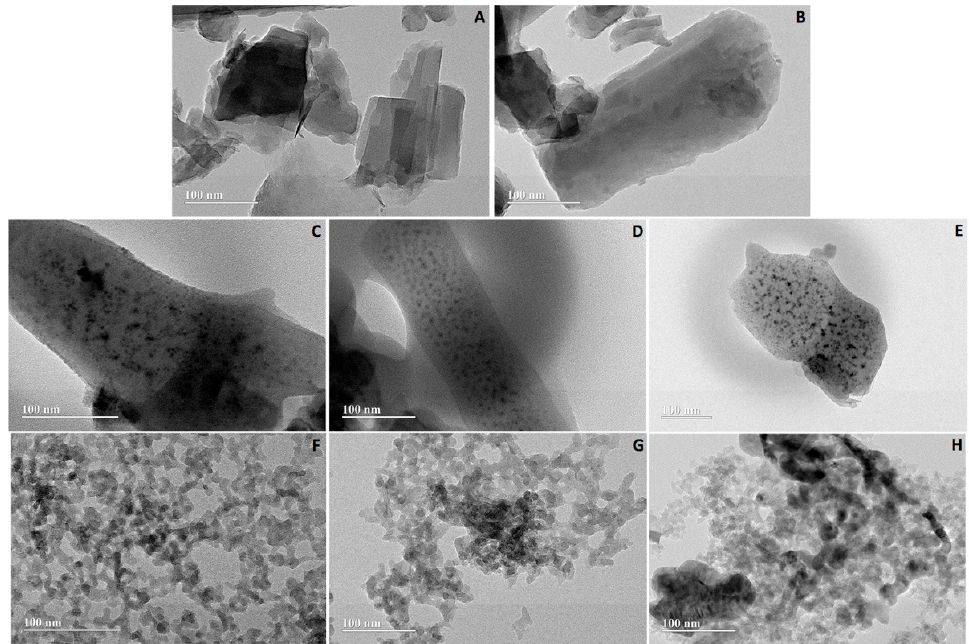
Figure 3. Transmission electron microscopy images of parent zeolite support and prepared single and double metal oxides supported on modified natural zeolite and fumed silica: ( A ) ZNAT; ( B ) ZH; ( C ) ZH_Cu; ( D ) ZH_Zn; ( E ) ZH_Zn/Cu; ( F ) FS_Cu; ( G ) FS_Zn; and ( H ) FS_Zn/Cu.